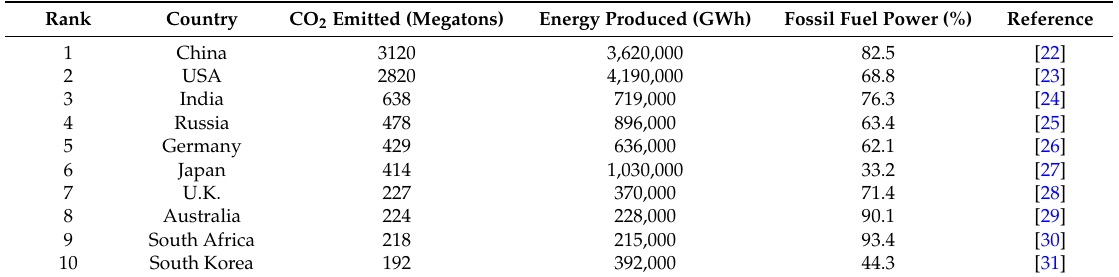
Table 1. World’s largest CO 2 emitting coal-fired power plants by